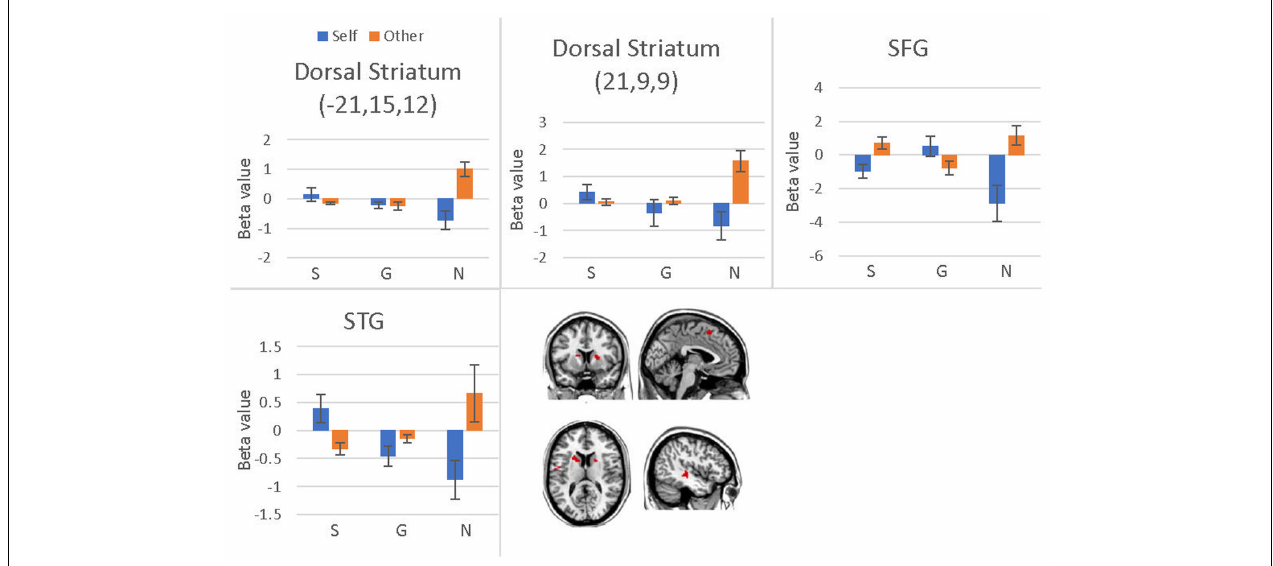
FIGURE 8 | Brain regions involved in the social influence and subjects’ choices interaction, p < 0.001, cluster size = 10, uncorrected. Y -axis represents the beta value. G, generous influence; S, selfish influence; N, no social influence (Error bars indicate standard errors of the